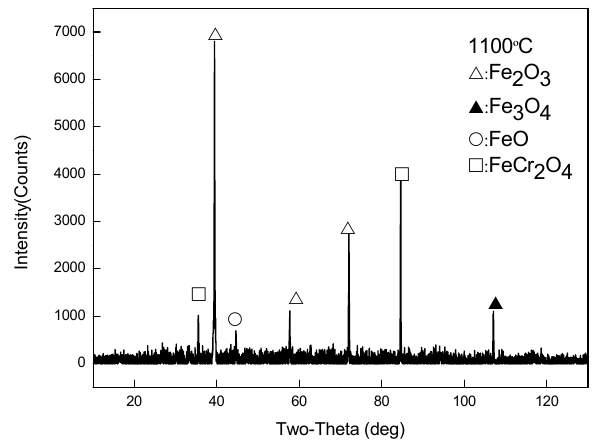
Figure 11. XRD data for the oxide scales obtained at 1000 °C.